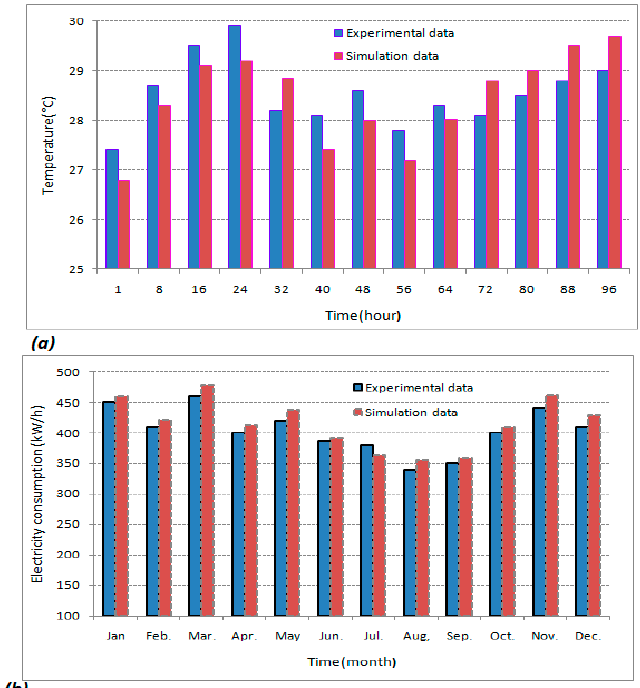
Figure 5. Experimental and simulation data. Figure 5. ( a , b ) Experimental and simulation